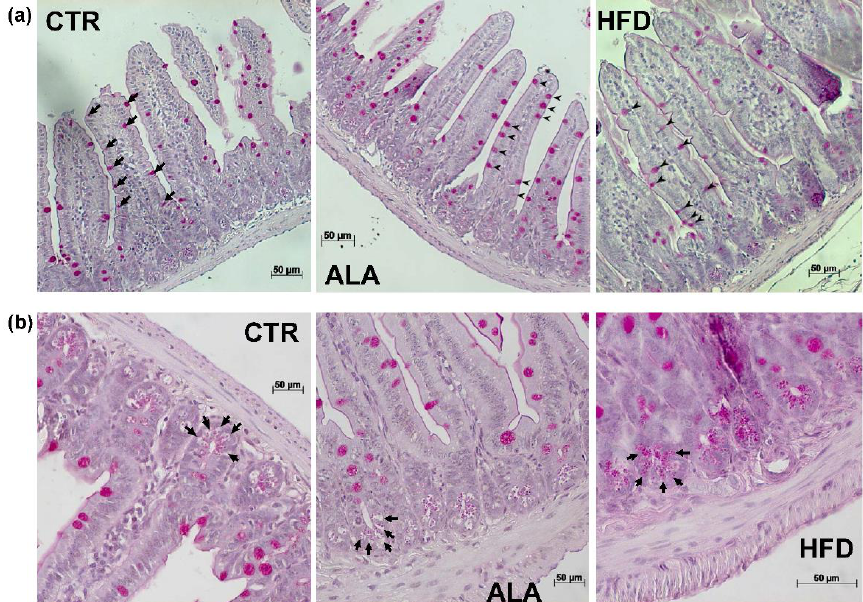
Figure 6. Impact of ALA-rich diet and Western-type high-fat diet (HFD) on villus morphology of the mid small intestine. Morphometric analysis of ( a ) mucosal thickness, ( b ) villus length, ( c ) crypt depth, and ( d ) villus spacing. Counts of ( e ) epithelial cells, ( f ) goblet cells, ( g ) Paneth cells. Based on Ki67 stained cells the proliferation rate was calculated ( h ). Bar plots show mean values + standard error of the mean (SEM). n = 6 in the CTR group, n = 6–7 in the ALA group and n = 7 in the HFD group. *** p < 0.001, ** p < 0.01, * p < 0.05, ANOVA followed by Dunnett’s post-hoc test. ALA: α-linolenic acid; CTR: control diet; HFD: Western-type high-fat diet.